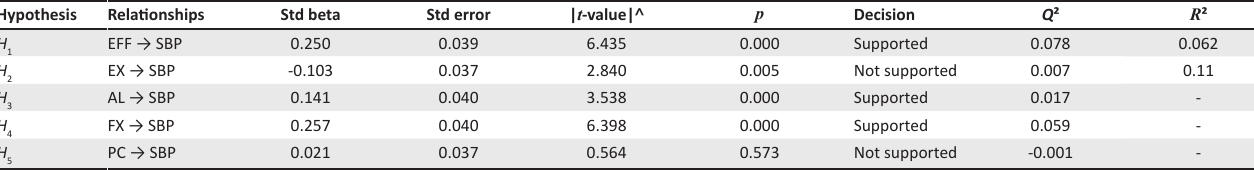
TABLE 3: Outcome of the test for hypothesised relationships. Hypothesis Relationships Std